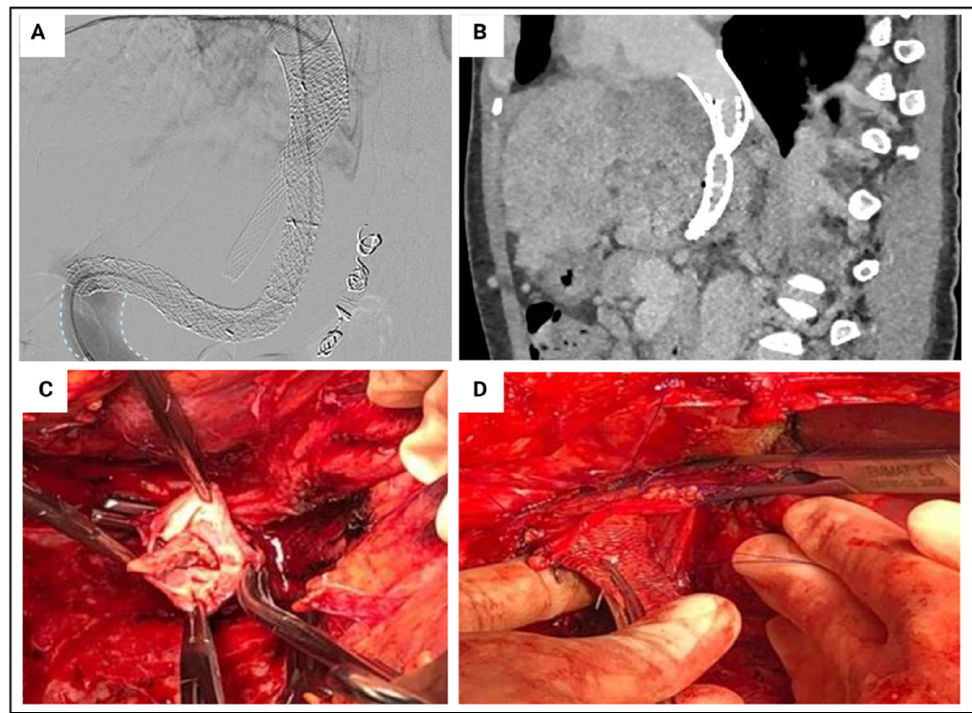
Figure 6. Budd–Chiari syndrome case example. Recipient: 45 year old female with Budd-Chiari syndrome secondary to Jak2 mutation. Previously managed with two hepatic vein stents, multiple venoplasties and a transjugular intrahepatic portosystemic shunt (Panel ( A , B )). Listed due to